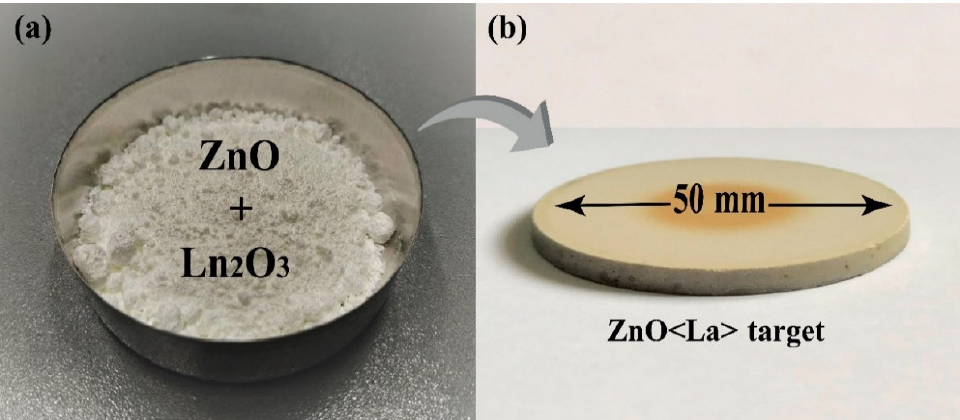
Figure 1. ( a ) Actual photographs of metal oxide powders and ( b ) ZnO<La> sputtering target.